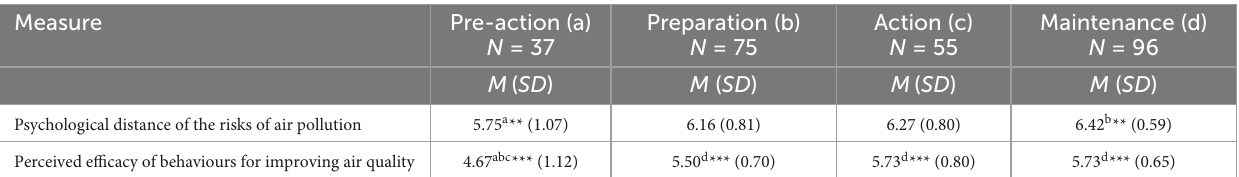
TABLE 1 Means , standard deviations and Games-Howell test (Study